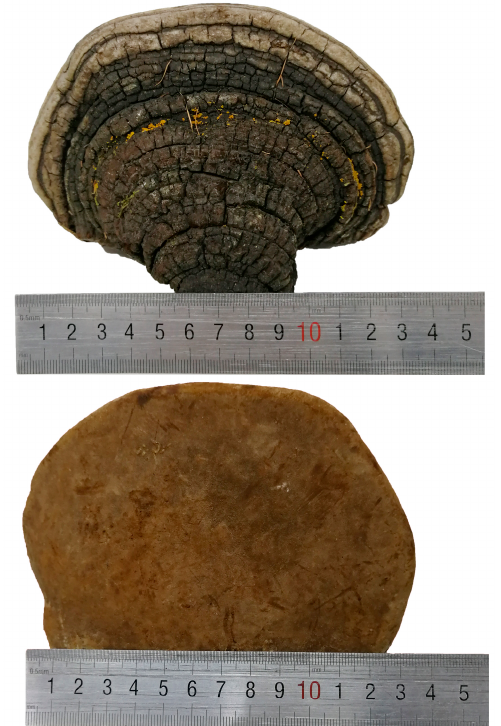
Figure 1. The fruiting body of Phellinus linteus .